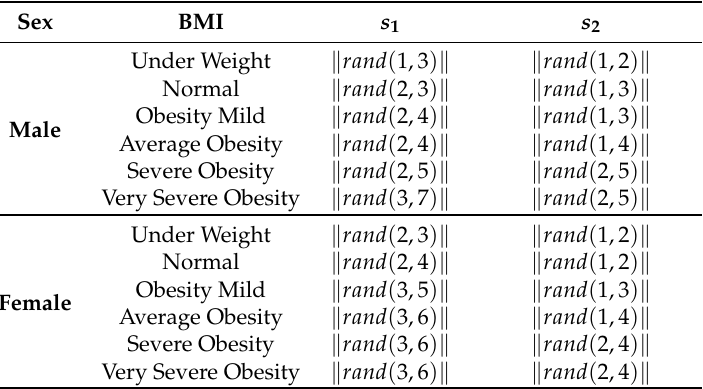
Table 1. Transition steps depending on the body mass index